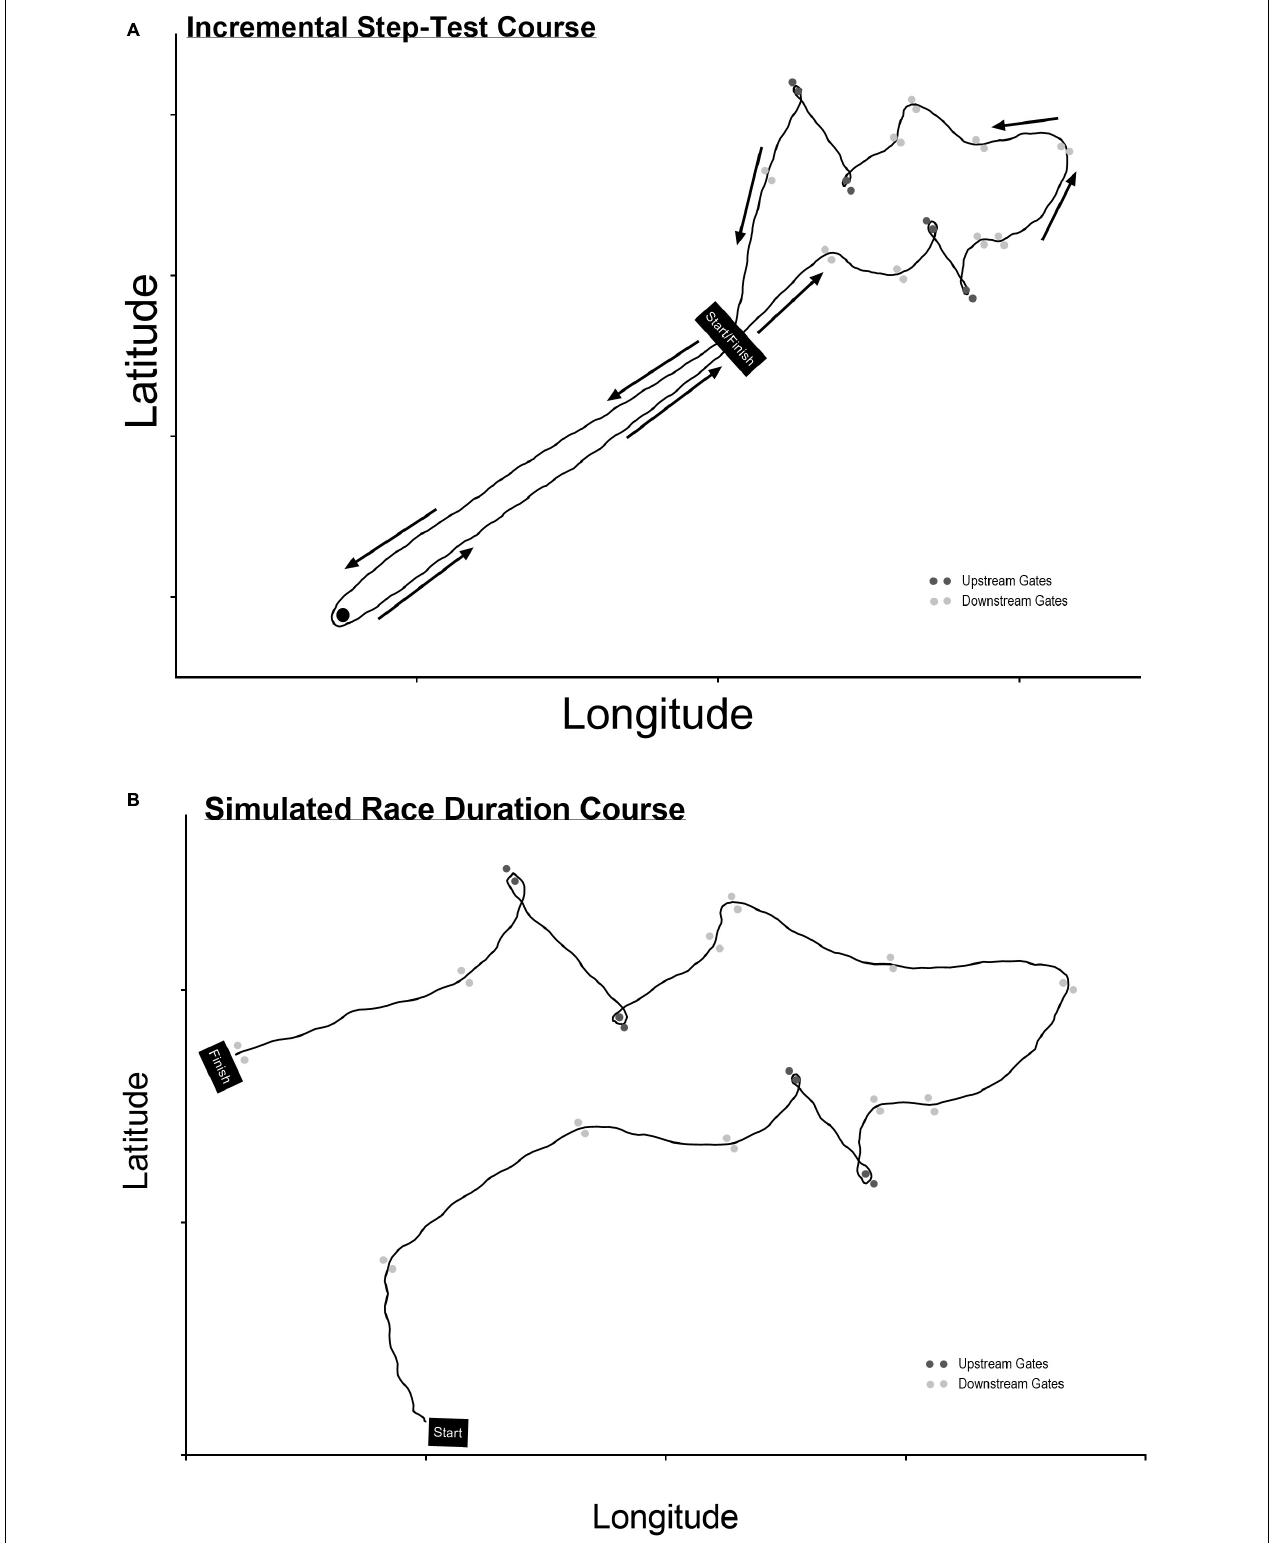
FIGURE 1 | The courses for the (A) incremental step-test and (B) race duration test. The line is taken from a participant’s high-speed GPS unit.